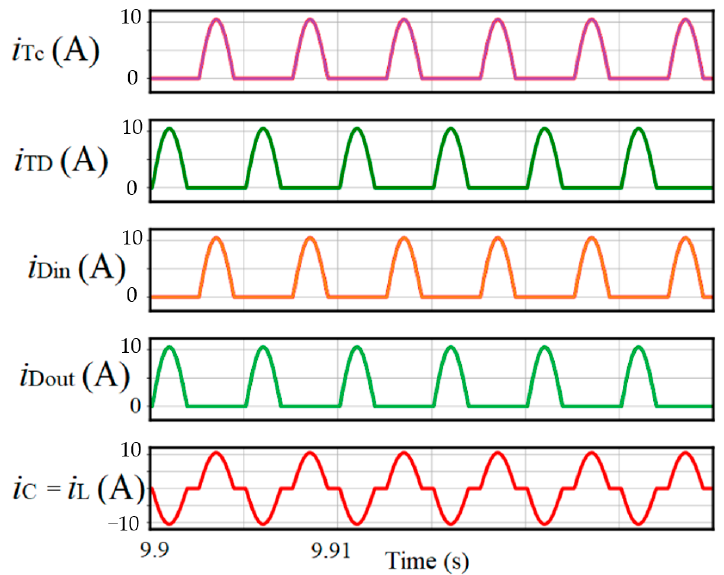
Figure 3. Current waveforms captured during simulation research performed on the proposed converter.